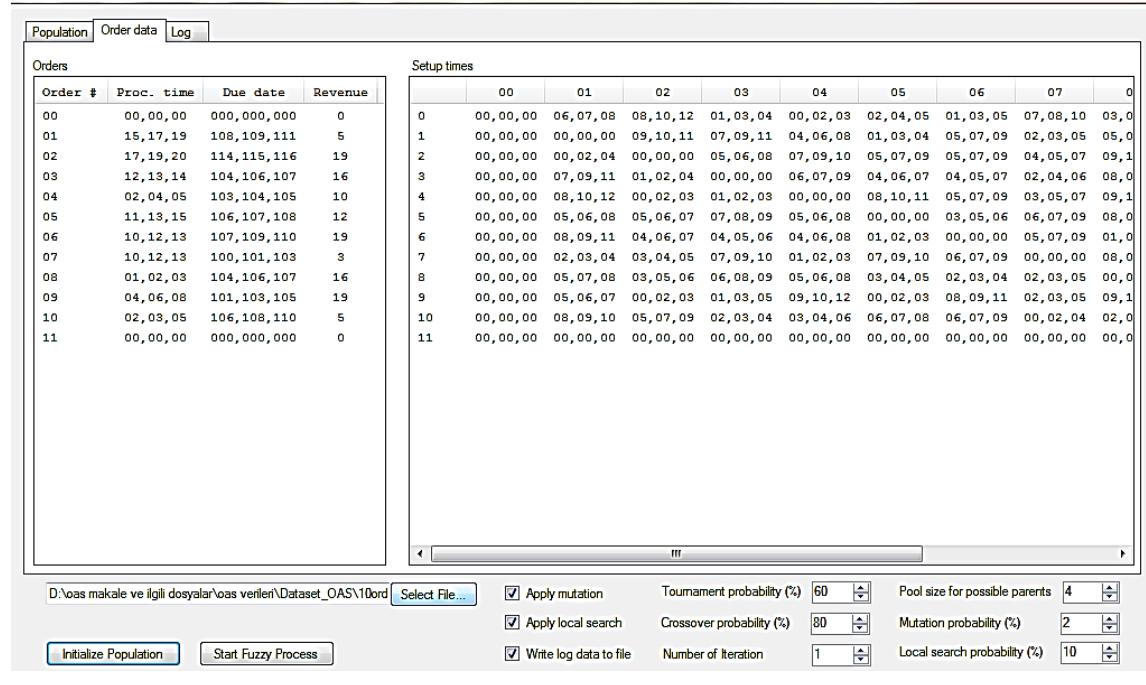
Figure A3. Data display screen